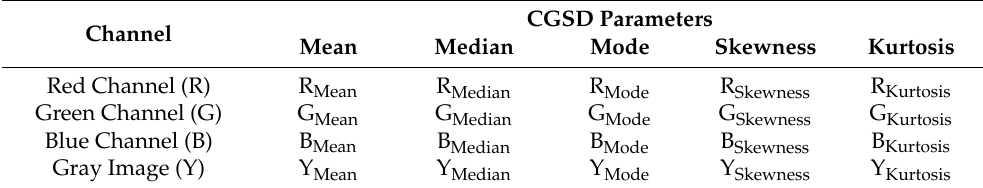
Table 1. Color gradation skewness-distribution (CGSD)